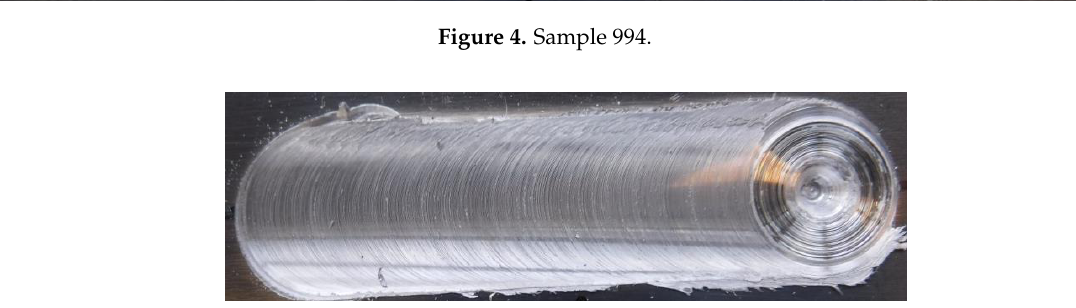
Figure 5. Sample 995.